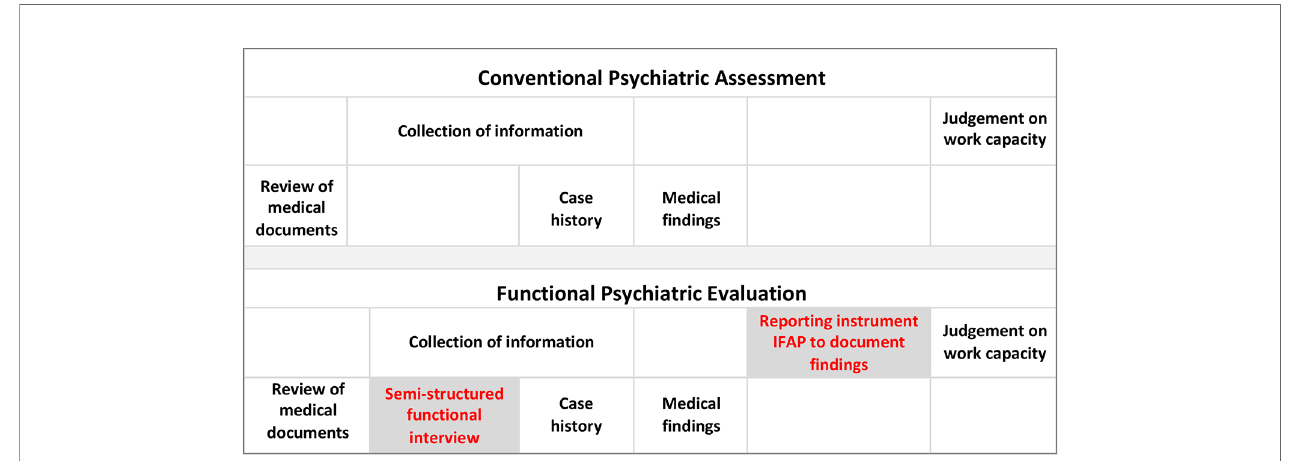
FIGURE 1 | Functional psychiatric evaluation complements conventional psychiatric assessment. Functional psychiatric evaluation consists of a semi-structured functional interview to elicit the patients ’ functional limitations and remaining capacities and the Instrument for Functional Assessment in Psychiatry (IFAP) to document them with reference to common work-related activities